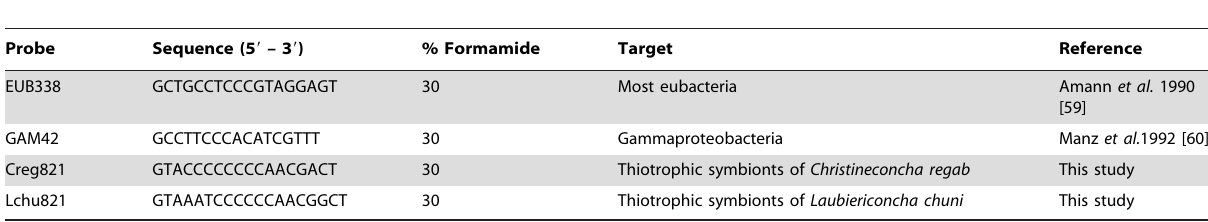
Table 2. FISH probes used in this study, percentage of formamide in hybridization buffer, and target groups.